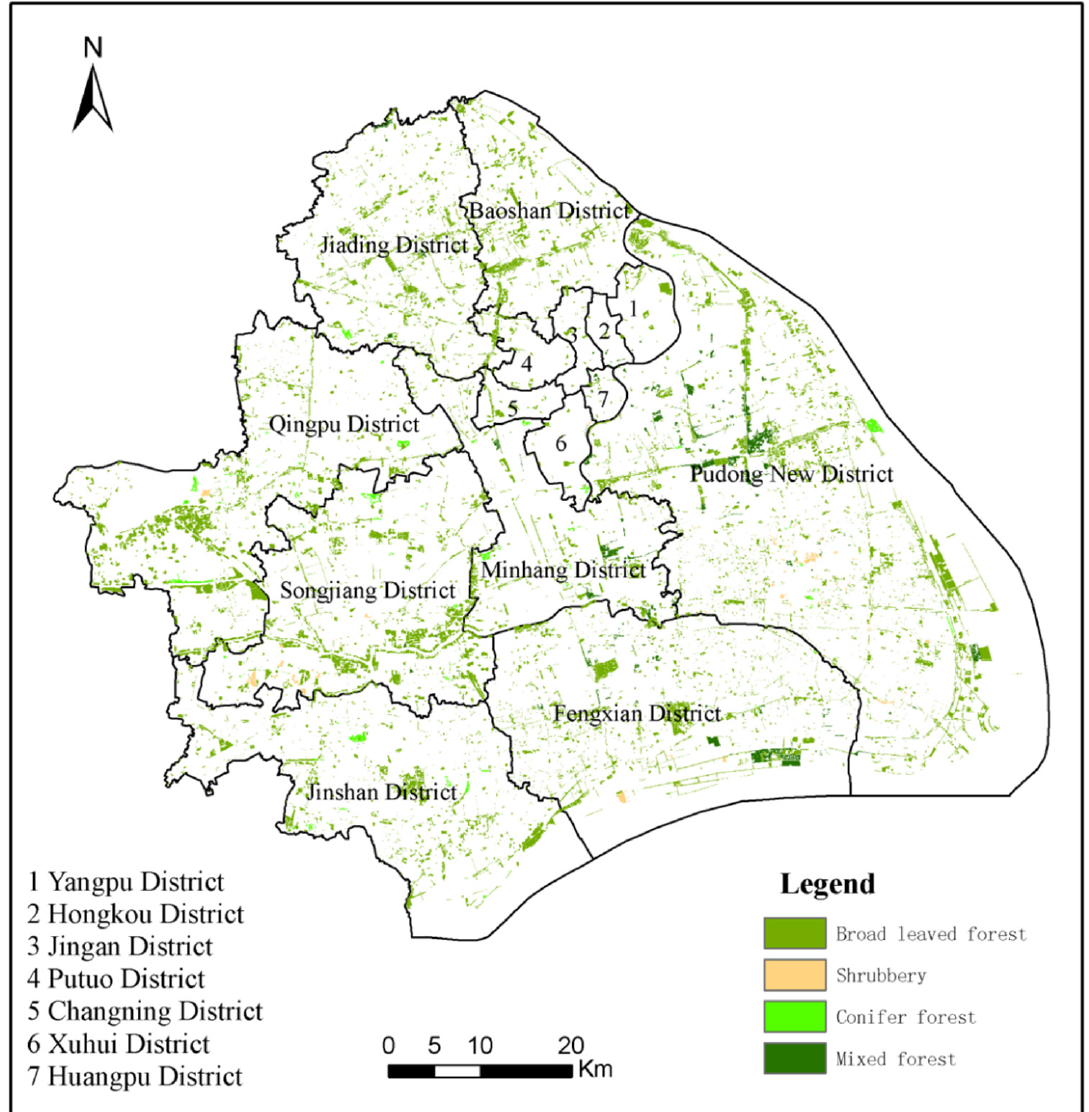
Figure 3. Spatial distribution of forest communities in urban areas in Shanghai.